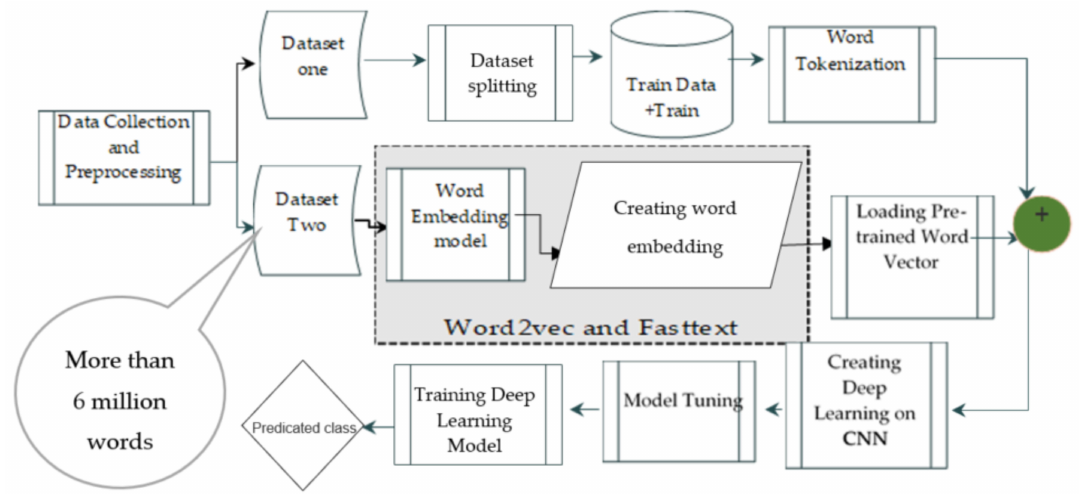
Figure 2. Block diagram of the overall architecture of our method. CNN, convolutional neural network.